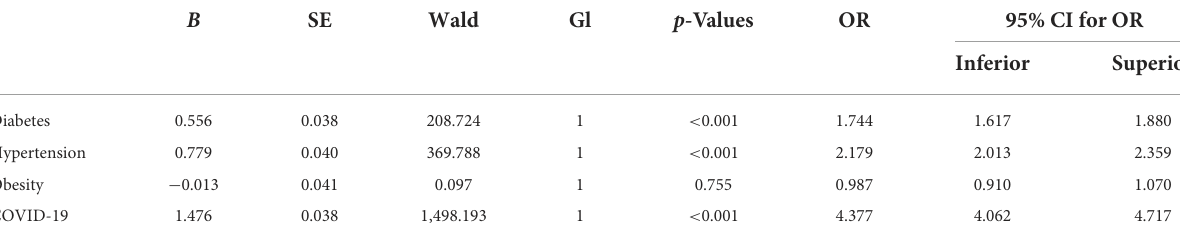
TABLE 4 Binary logistic regression analysis on death and comorbidities.